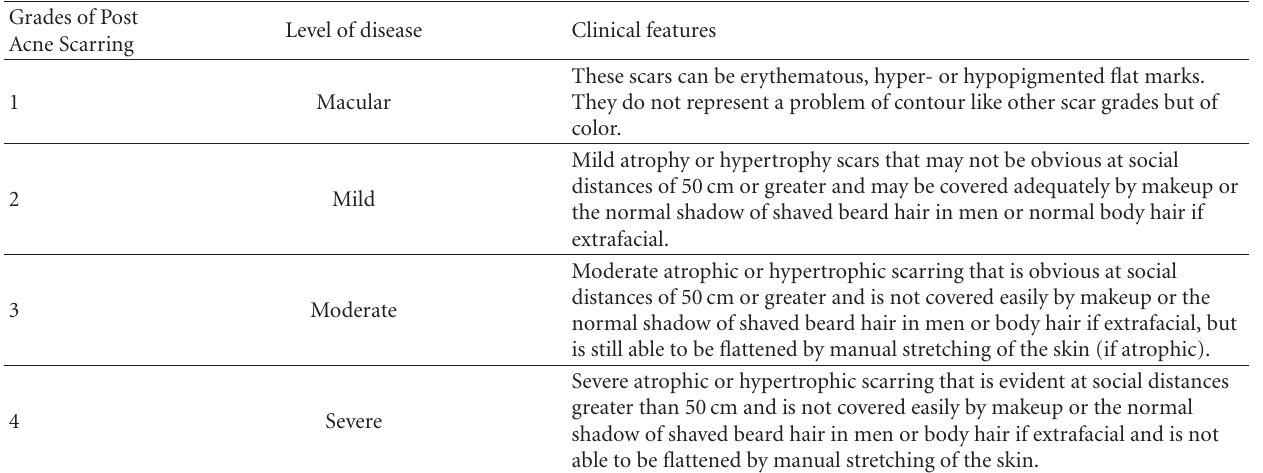
Table 2: Qualitative scarring grading system (adapted from